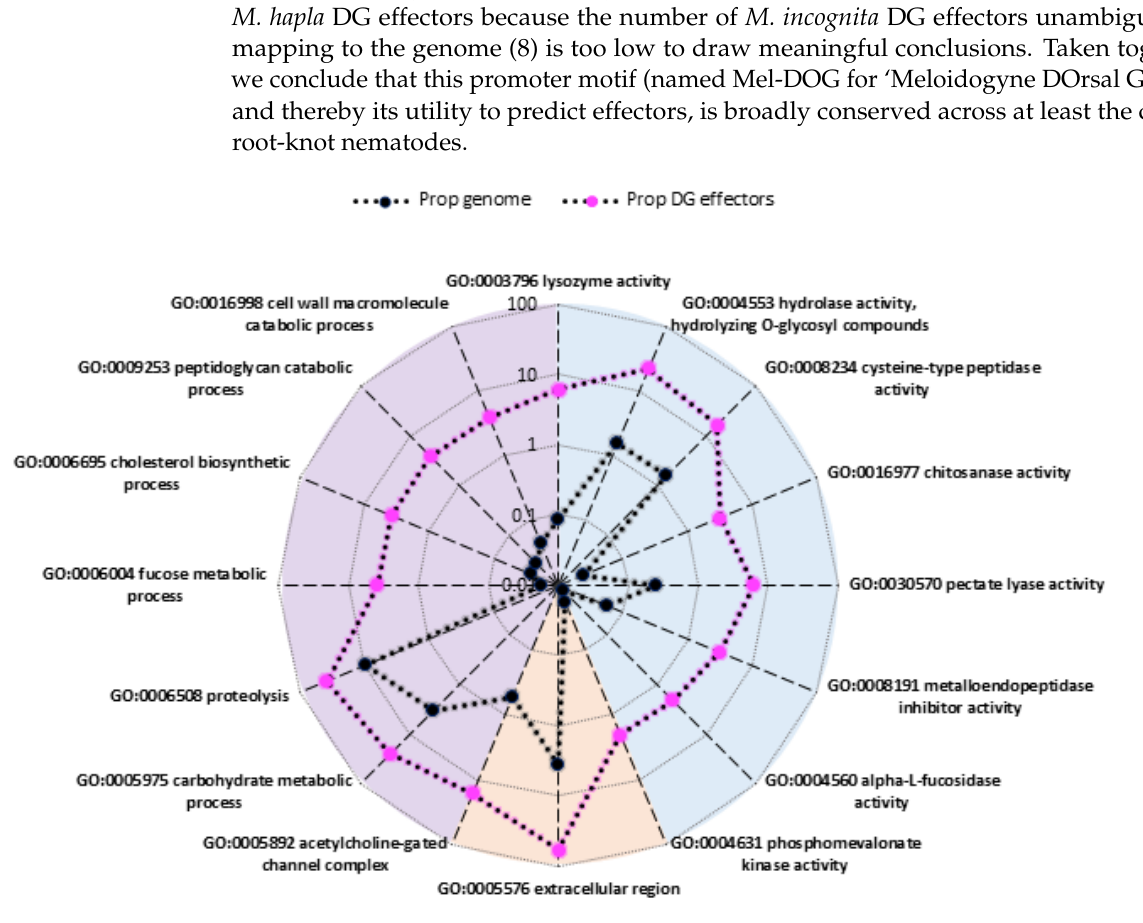
Figure 6. Radar plot with the GO terms overrepresented in the candidate DG effectors relative to the whole genome in a logarithmic scale. Dotted curves represent the percentage of proteins with a GO term having this specific GO term assigned (black: whole genome; magenta: candidate DG effectors). Biological process, molecular function, and cellular component GO terms are indicated with a purple, blue, and red background, respectively.